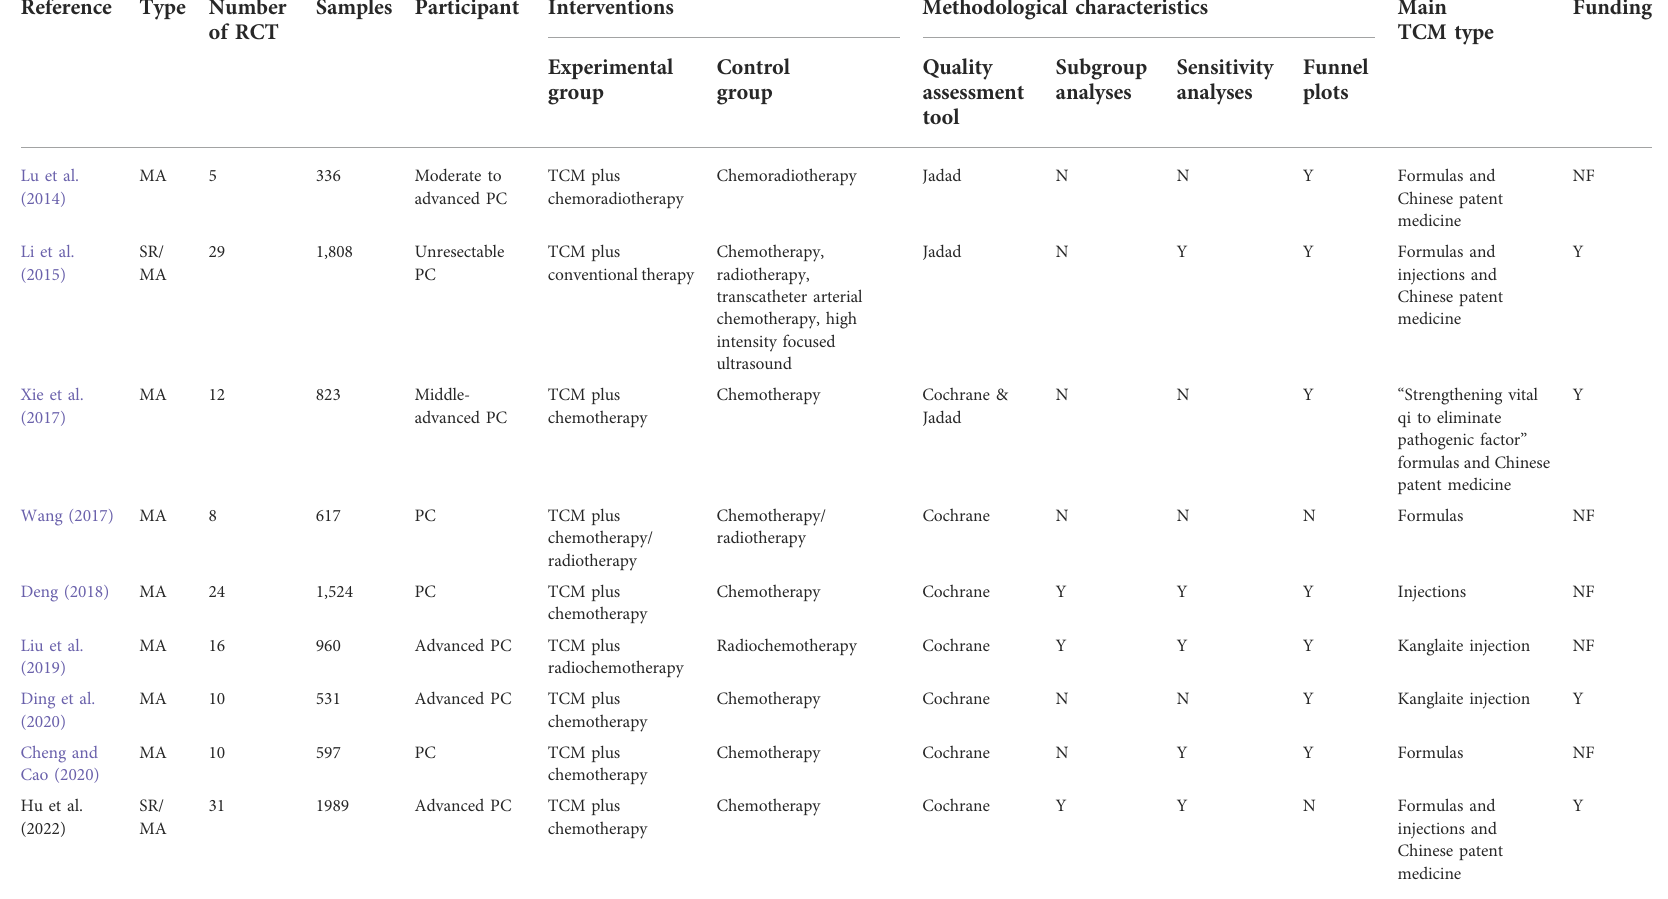
TABLE 1 Characteristics of the